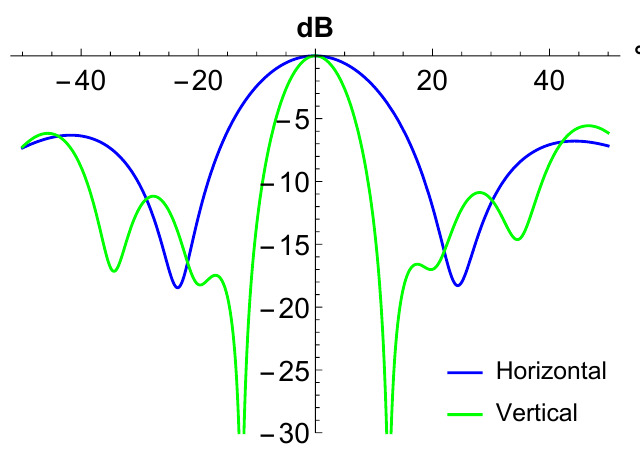
Figure 5. Response of the SAMI array to a point source at ( θ,φ ) = (0 , 0) at frequency 16 GHz. The maximum sidelobe is above − 7 dB in both the horizontal (blue) and vertical (green) planes.